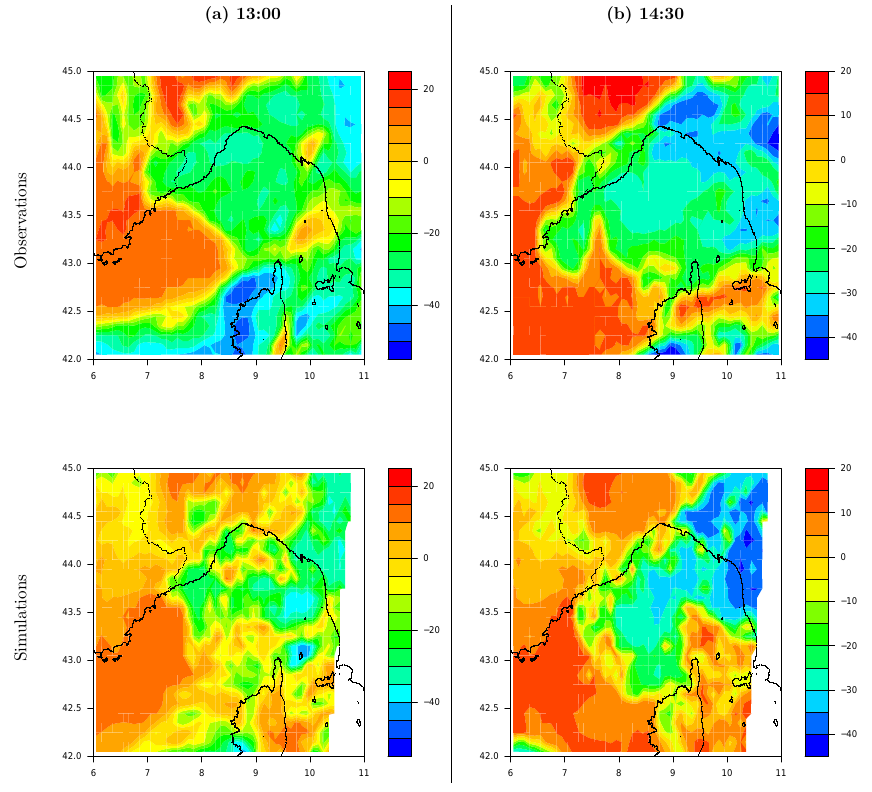
Fig. 13. 10.8µm infrared brightness temperature ( ◦ C) observed by SEVIRI onboard Meteosat satellite and simulated by Meso-NH at 2.5km resolution computed using the radiative transfer model RTTOV at 13:00 (a) and 14:30UTC (b)